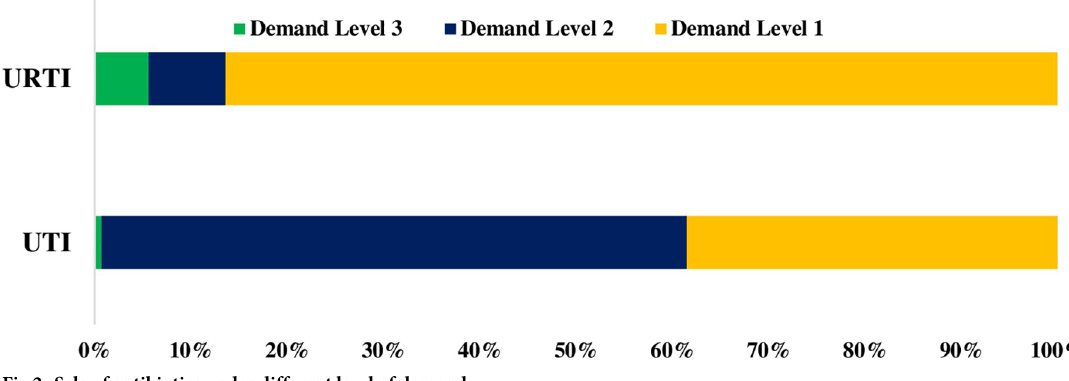
Fig 2. Sale of antibiotics under different level of